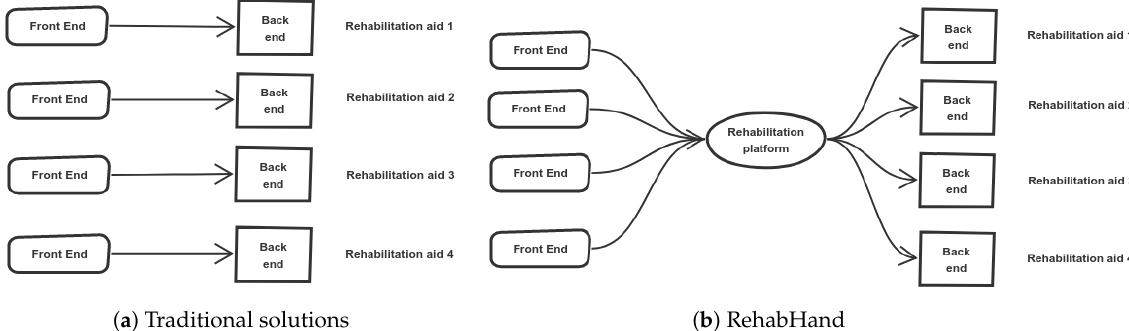
Figure 1. Comparison of RehabHand platform with traditional development and relationship between hardware and